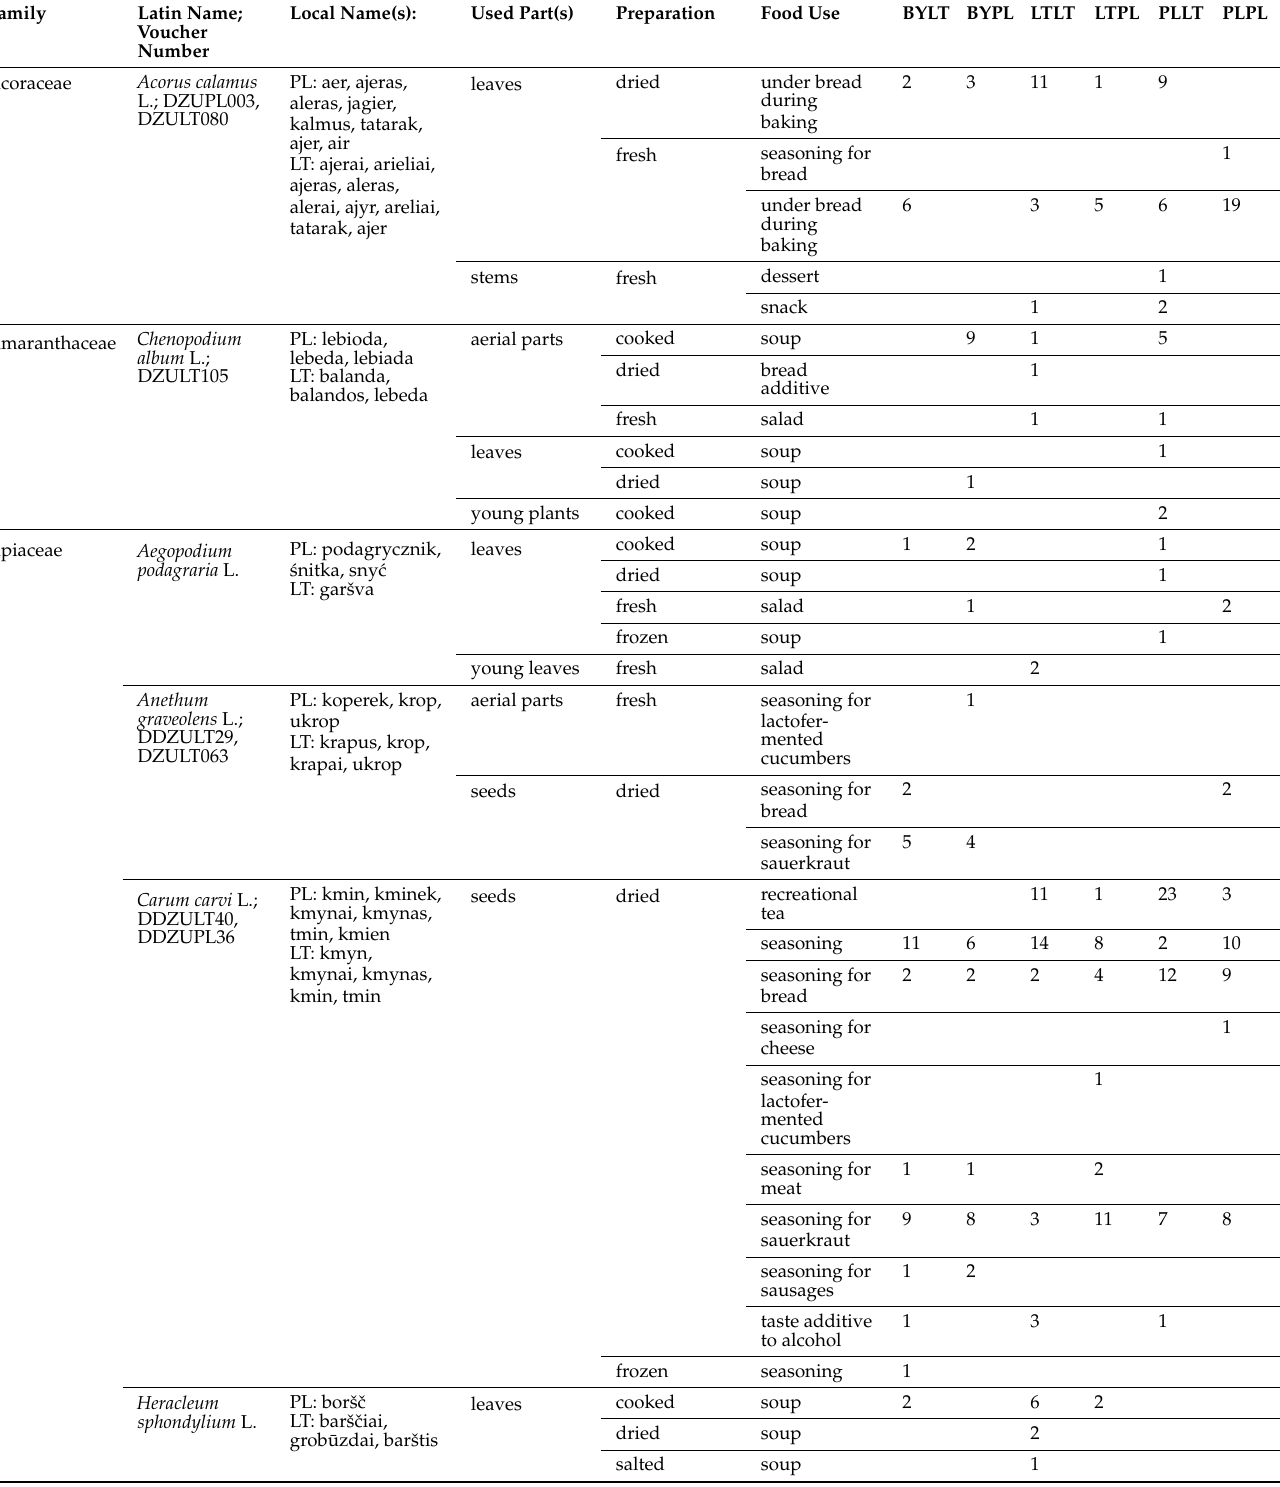
Table 2. Use of wild plants for food among Lithuanians living in Belarus (BYLT), Lithuania (LTLT), and Poland (PLLT); and Poles from Belarus (BYPL), Lithuania (LTPL), and Poland (PLPL). Local name (s): PL—mentioned among the Polish community; LT—among the Lithuanian